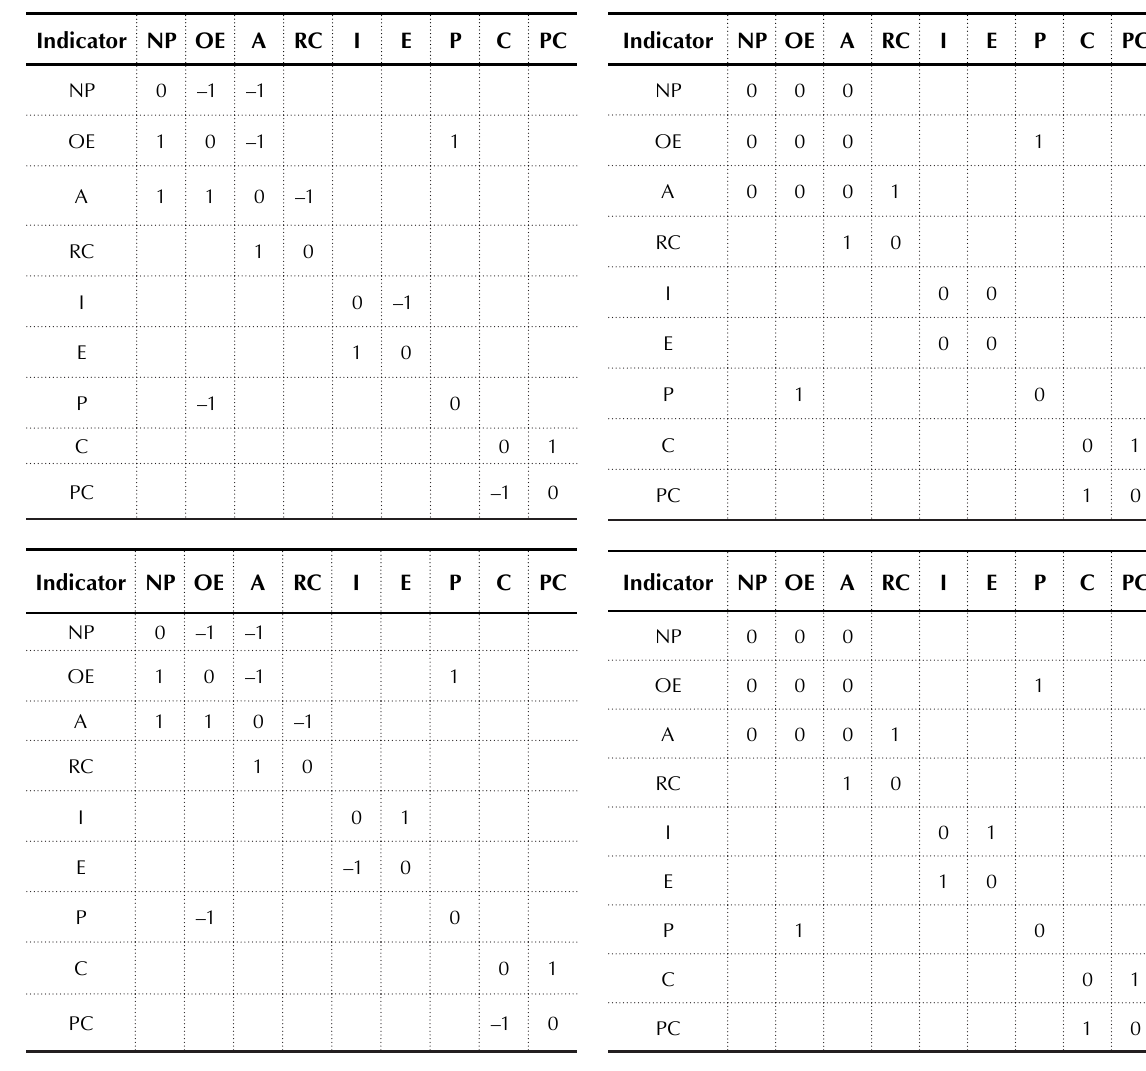
Table 7. The matrix of actual ratios Table 8 . Matrix of matches of actual